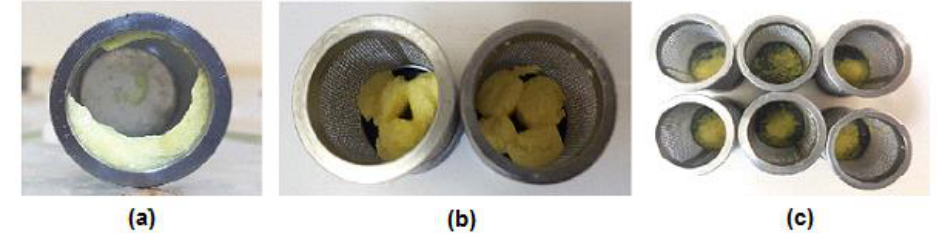
Figure 3. Visual representation of ( a ) hypromellose gel matrix formed by Coartem ® ; ( b ) example of relatively intact formulated lipid matrix tablets produced in this study after 750 min dissolution, highlighting the effect of polymer relaxation; and ( c ) example of formulated lipid granules that once contained active pharmaceutical ingredient particles within lipid matrix tablets, demonstrating erosion release dissolution profiles.